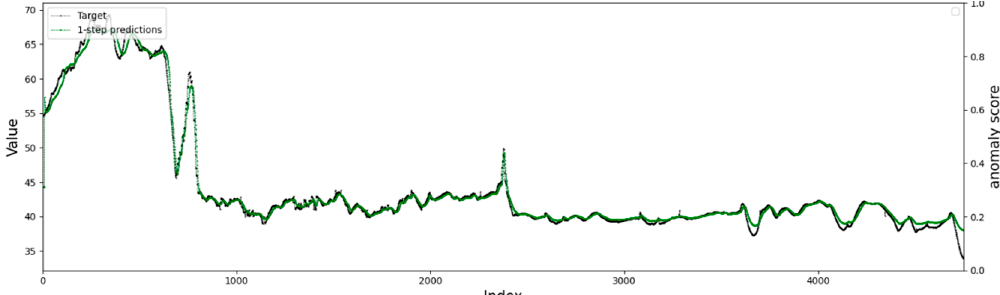
Figure 14. The result of the 1-step prediction. Figure 15. The result of the 10-step prediction.